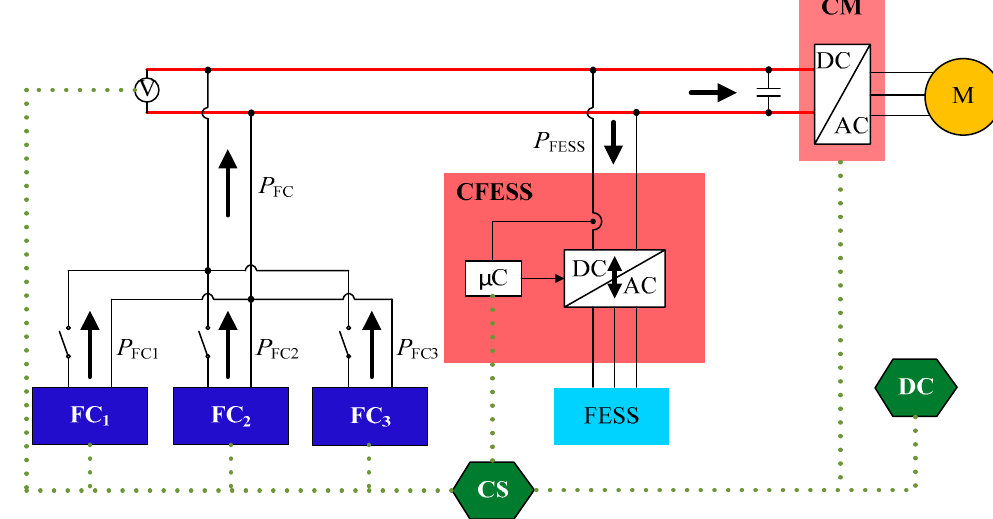
Figure 2. Schematic of the hybrid powertrain.